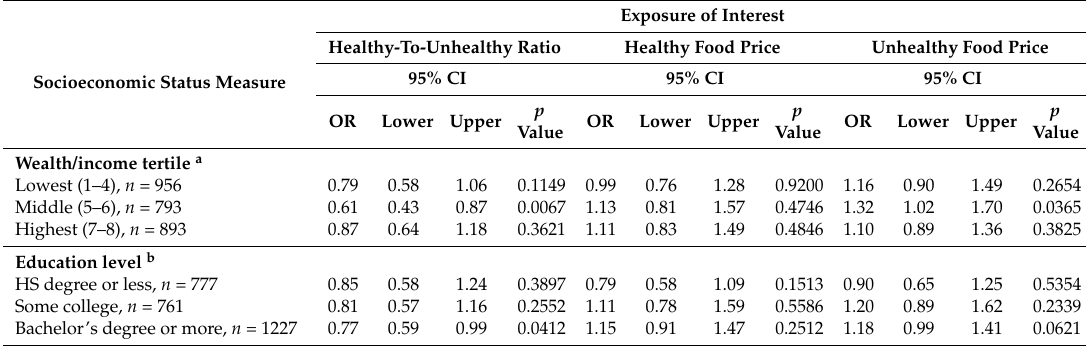
Table 4. Odds ratios of having a high-quality diet associated with the price ratio, and with the prices of healthy foods and unhealthy foods, stratified by wealth/income and by education ( n = 2765). Exposure of Interest